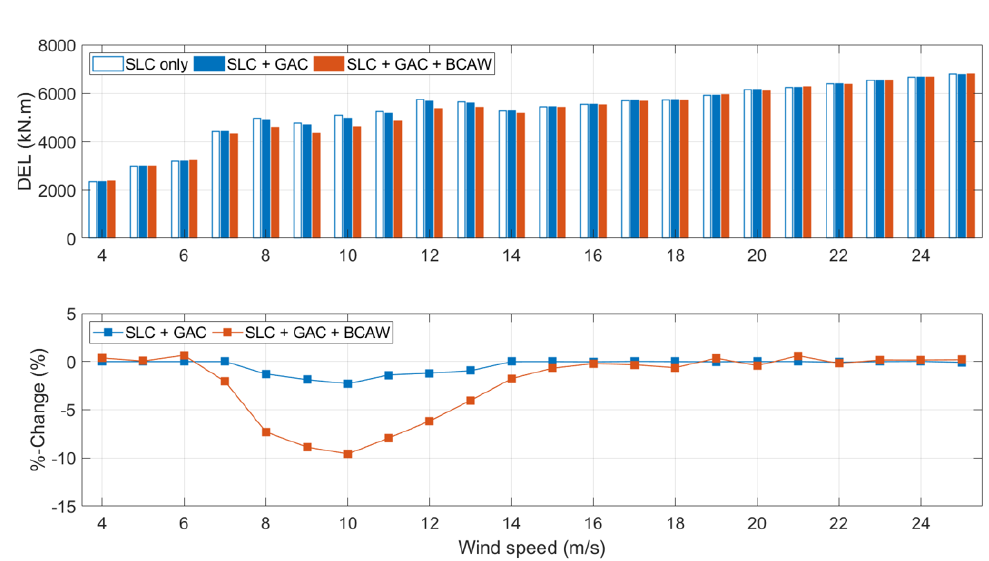
Figure A4. Variation of the DELs of the blade root flapwise bending moments from cut-in to cut-out wind speed under DLC 1.2 with different control architectures. Top—Dimensional DELs; Bottom— Percentage changes with respect to the ‘SLC Only’ case.